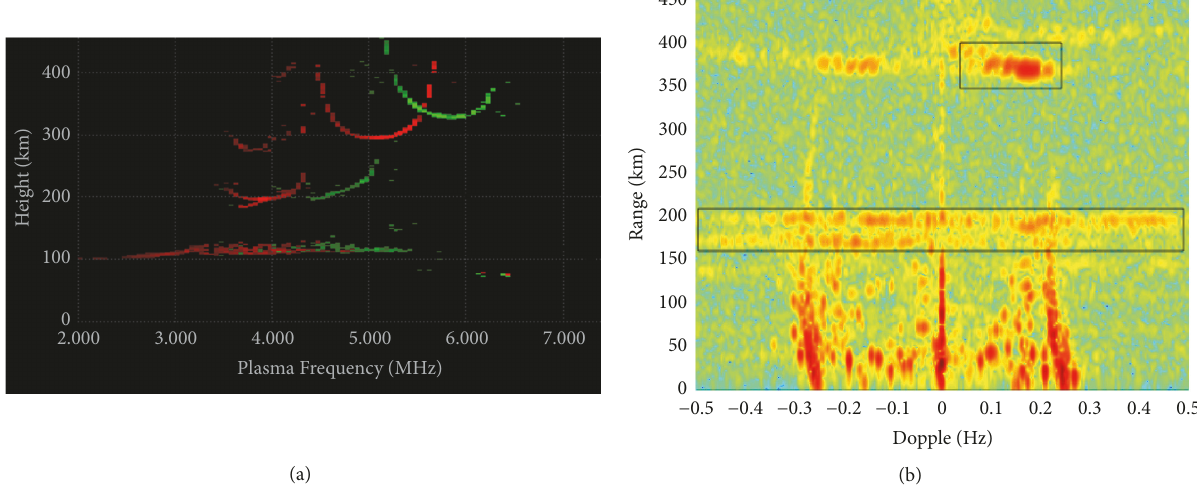
Figure 9: The comparison of Ionogram and RD spectrum of HFSWR on 10:55 am, June 28, 2018 (Beijing Time), location: Weihai (37.5 ∘ N, 122 ∘ E): (a) Ionogram; (b) RD